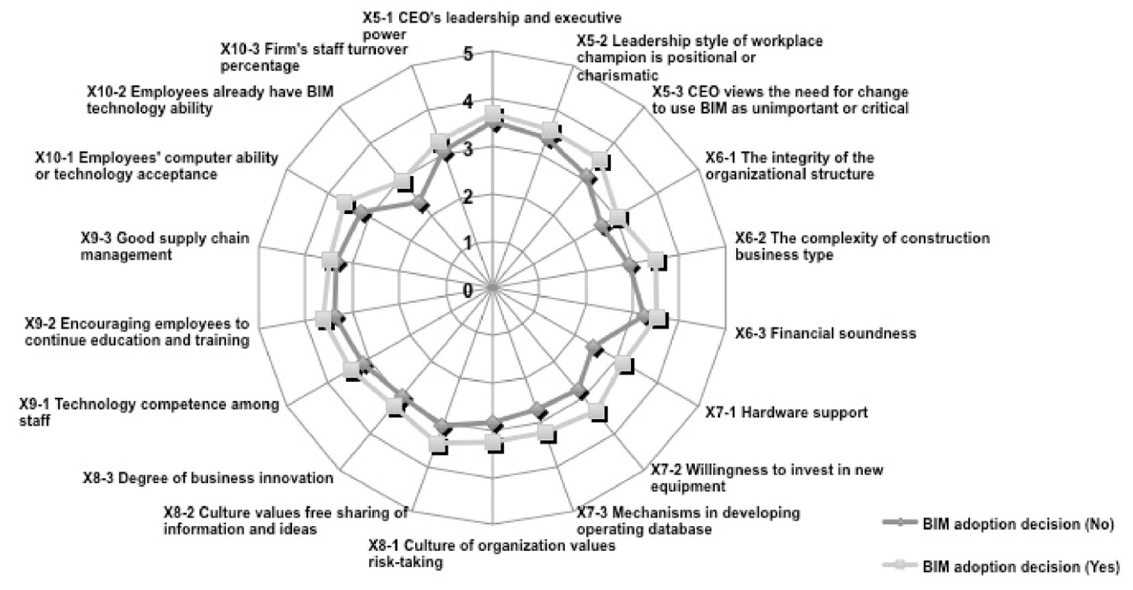
Fig. 2. Organizational readiness assessment for BIM users and